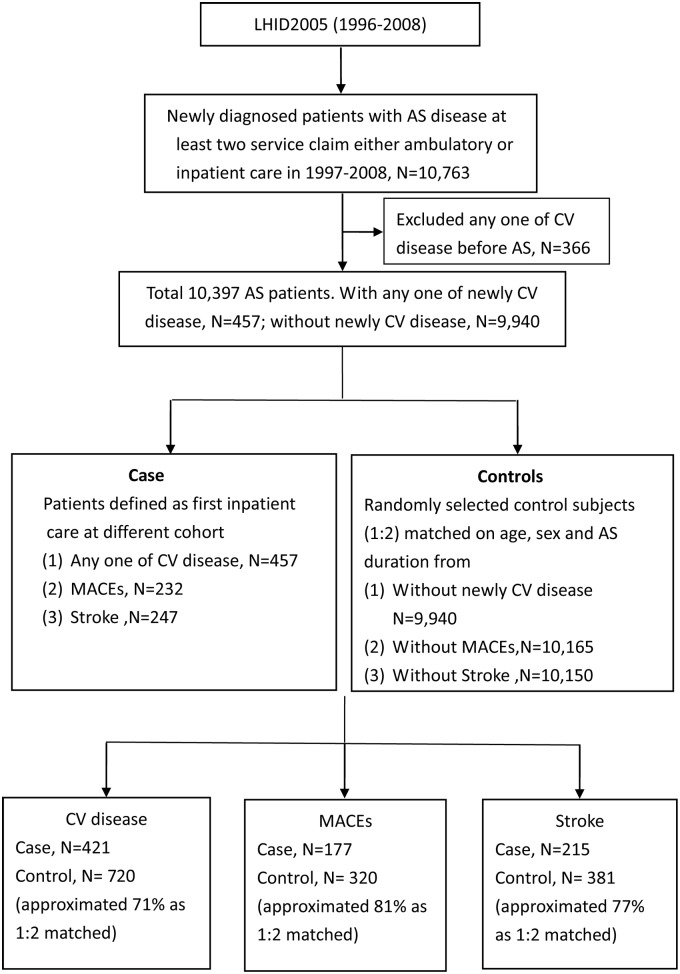
Consort diagram.Abbreviations: AS, ankylosing spondylitis; CV disease, cardiovascular disease; MACEs, major cardiovascular events; LHID, longitudinal health insurance database.